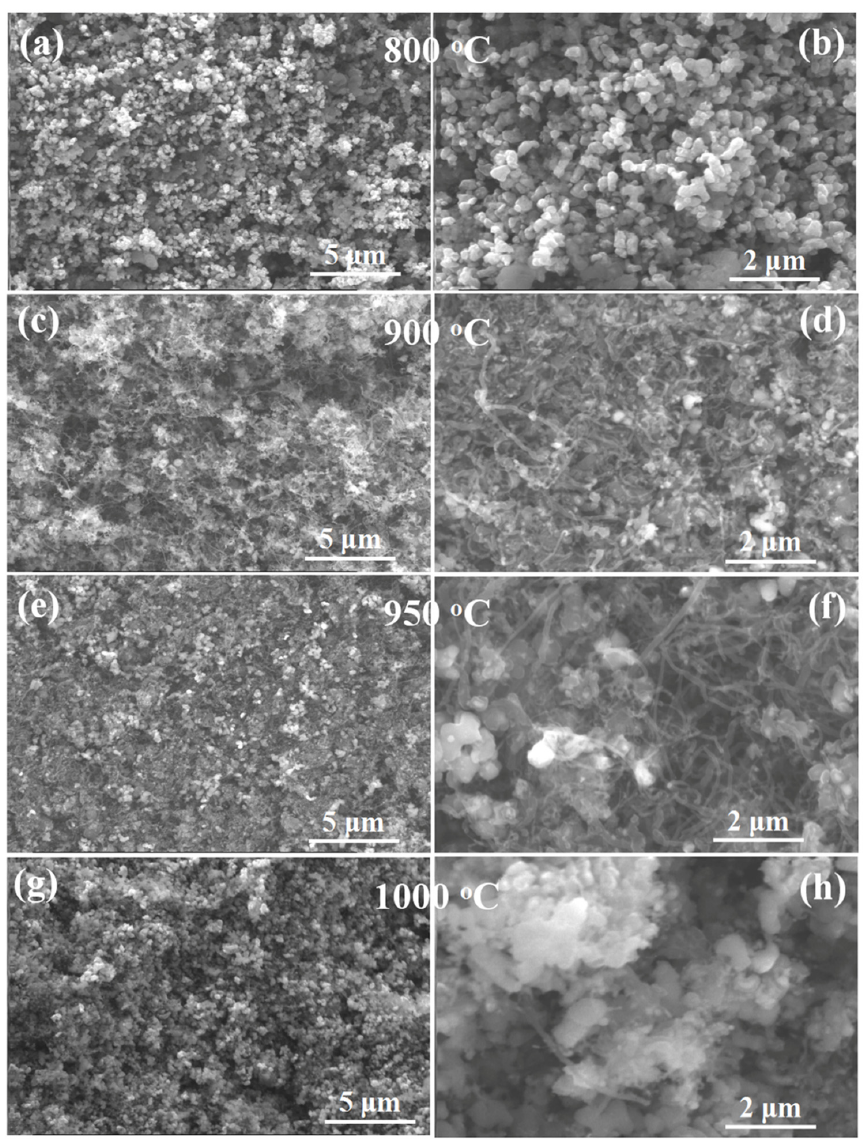
Figure 10. SEM images of CNCs synthesized at 800 °C ( a , b ), 900 °C ( c , d ), 950 °C ( e , f ), and 1000 °C ( g , h ) with the NiCo/ α –Al 2 O 3 catalyst.